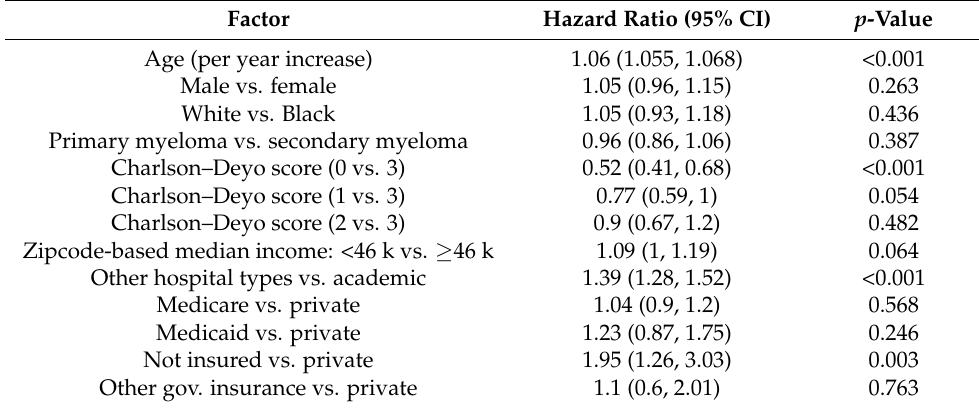
Table 3. Multivariable Cox model: based on subjects with age ≥ 65 years